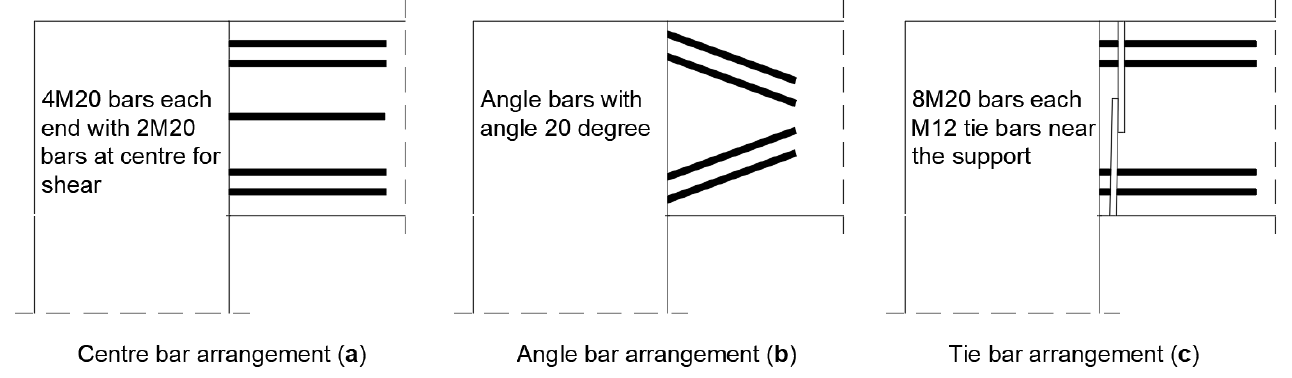
Figure 17. Specimen arrangements [49].